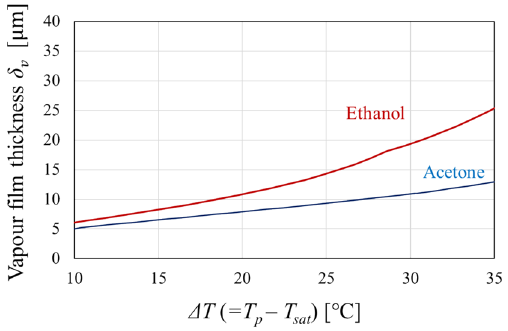
Figure 2. Estimation of vapour film thickness. The vapour film thickness was estimated using Eq. (1) for each droplet liquid. The red and blue curves indicate δ v for ethanol and acetone,